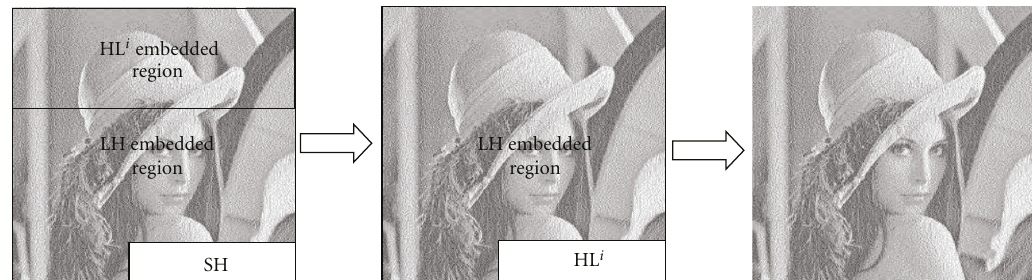
Figure 11: The flowchart of data extracting process.